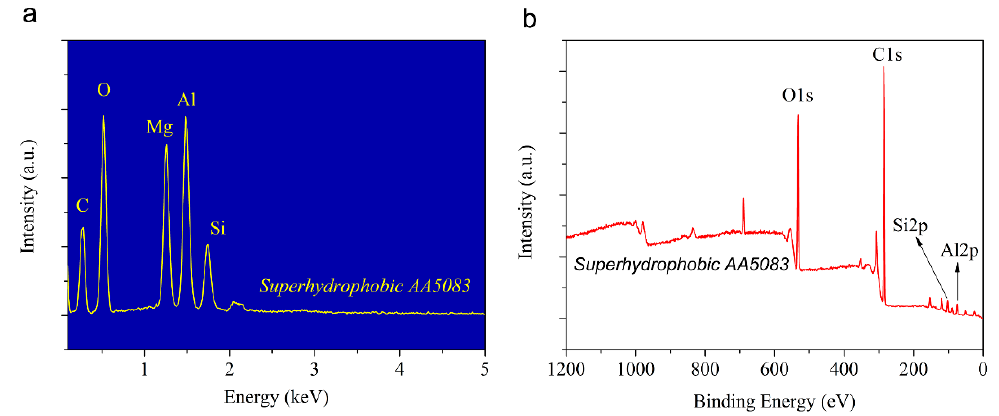
Figure 5. Energy dispersive X-ray spectroscopy (EDS) and X-ray photoelectron spectroscopy (XPS) spectra of the fabricated superhydrophobic AA5083 sample. ( a ) EDS spectrum, and ( b ) XPS spectrum.